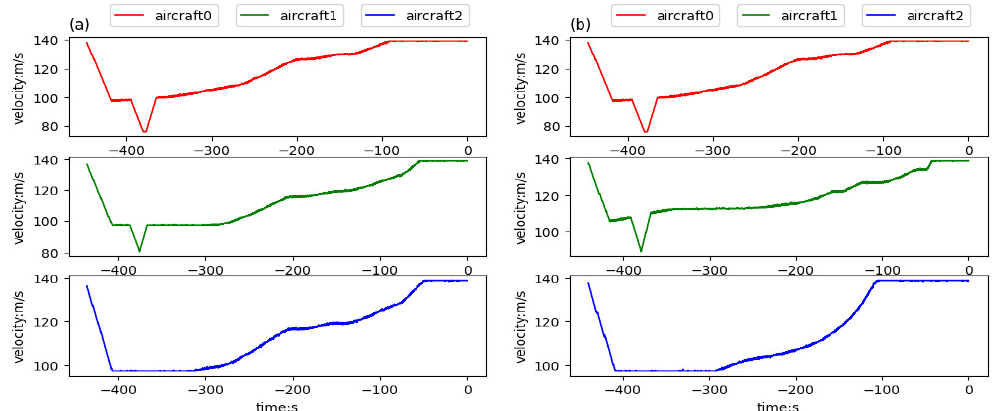
Figure 18. Velocities of aircraft trained in team aircraft guidance: ( a ) three aircraft starting in the same aerospace, flying to the aimed for 4D waypoints, respectively, and ( b ) three aircraft starting in different aerospaces, flying to the aimed for 4D waypoints,